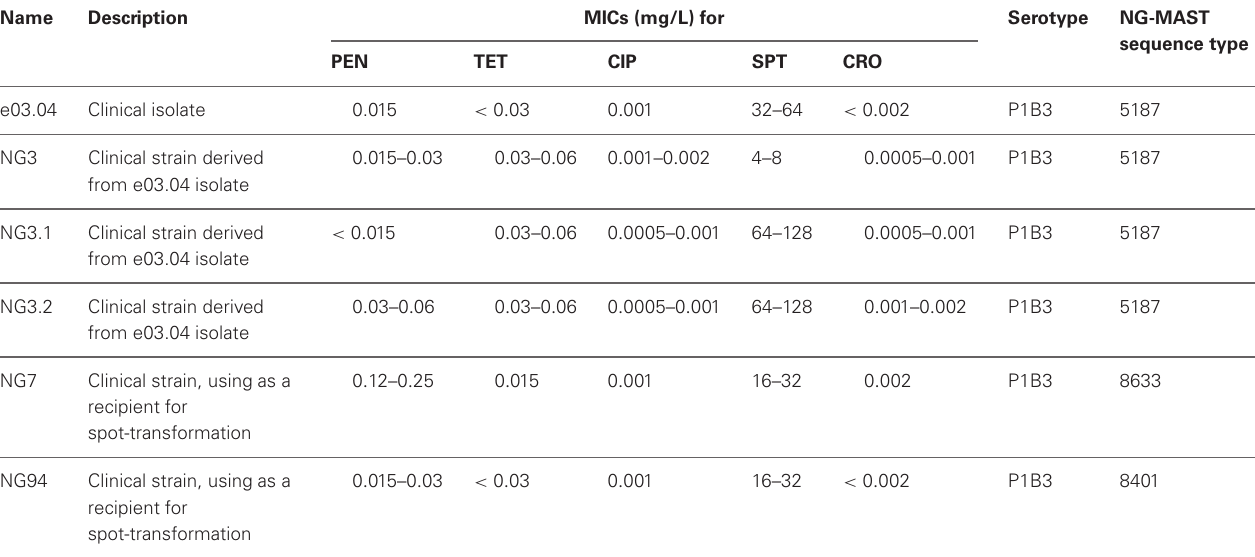
Table 1 | Characteristics of gonococci involved into current